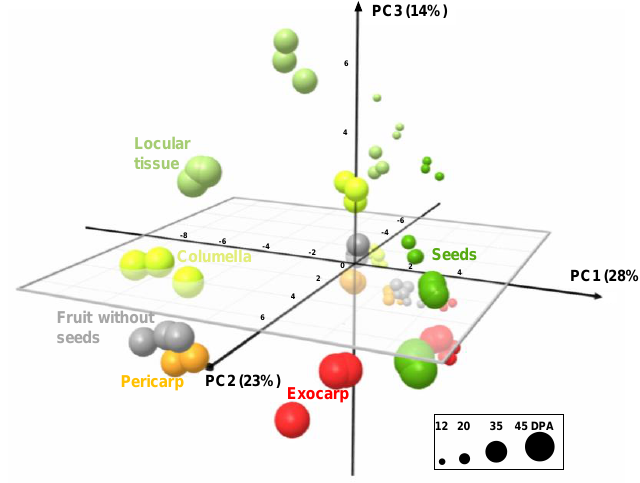
Figure 4. PCA of absolute values of 39 metabolites and starch measured by proton nuclear magnetic resonance ( 1 H-NMR), liquid chromatography coupled with diode array detection (LC-DAD), or enzymatic analyses in five tomato fruit tissues and fruit without seeds at four stages of development, and expressed on a DW basis. 3D scores plot for PC1, PC2, and PC3. Exocarp in red, mesocarp with endocarp in orange, columella with placenta in yellow, locular tissue in light green, seeds in dark green, and fruit without seeds in light grey.